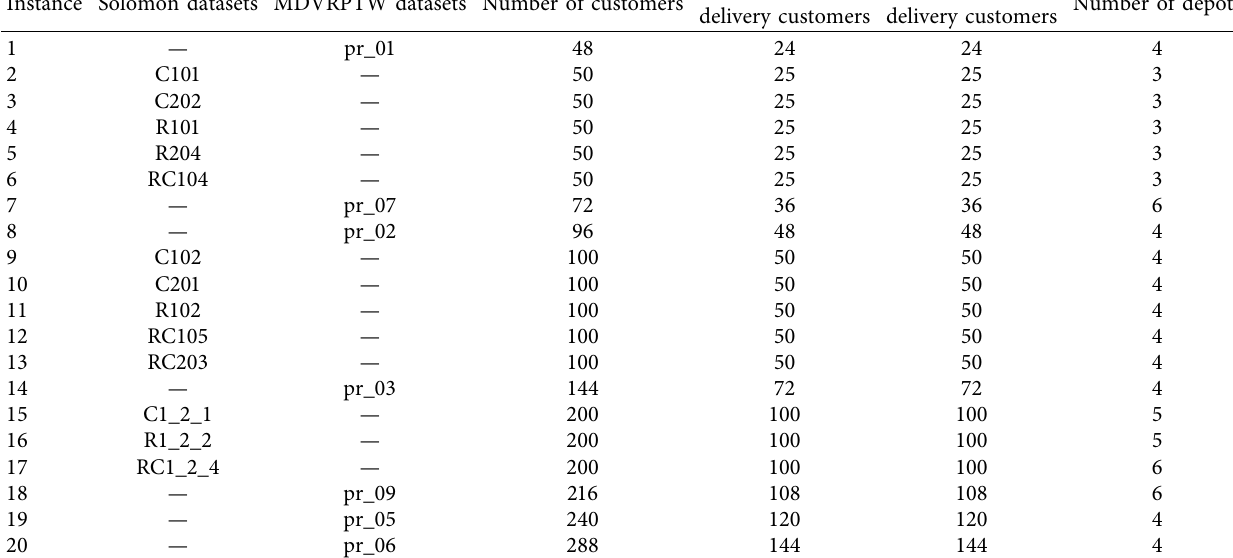
Table 5: Parameters in the datasets.